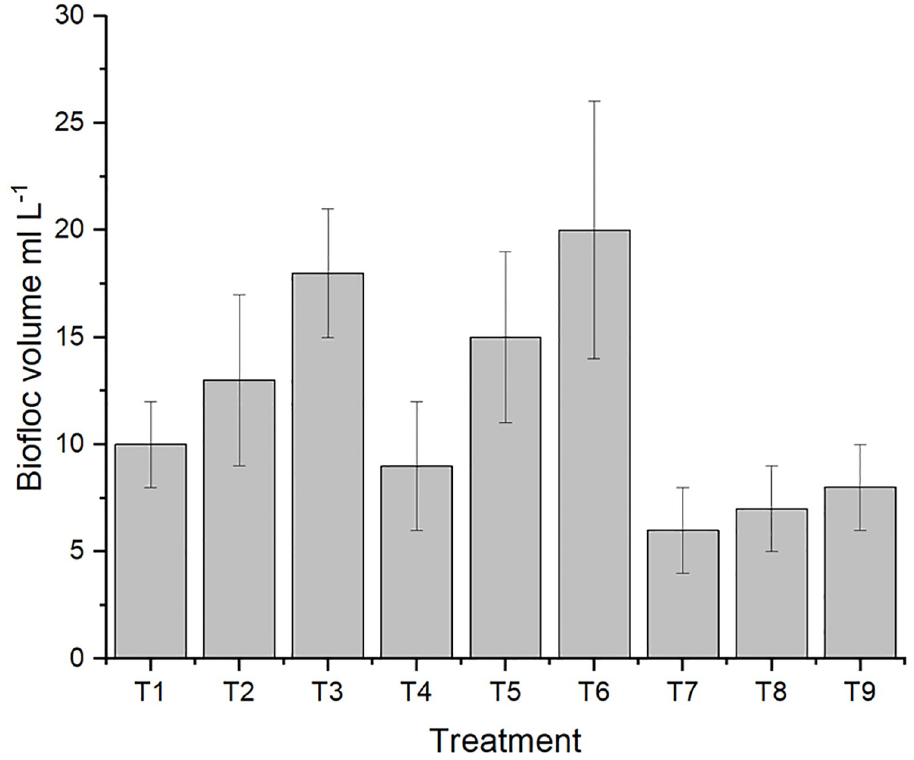
Fig 1. The effect of C/N ratio and frequent addition on biofloc volume. A factorial experimental design included carbon source (starch) frequent addition on daily basis (once, twice, triple) and C/N ratio (10, 15, 20). T1; once C/N 10, T2; once C/N 15, T3; once C/N 20, T4; twice C/N 10, T5; twice C/N 15, T6; twice C/N 20, T7; triple C/N 10, T8; triple C/N 15, T9; triple C/N 20.